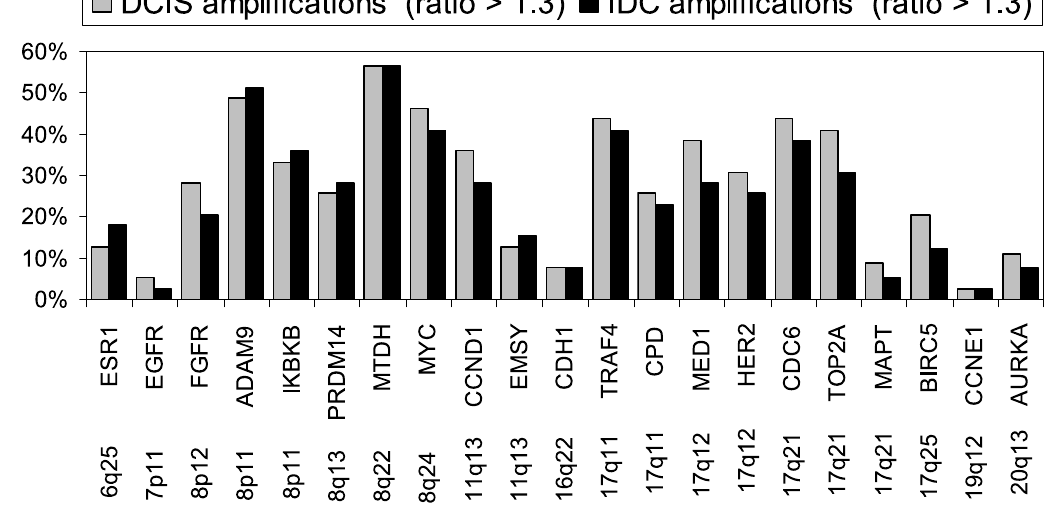
Fig. 1. Amplification frequencies of 21 genes analyzed by multiplex ligation-dependent probe amplification (MLPA) in DCIS and adjacent IDC from 39 breast cancer